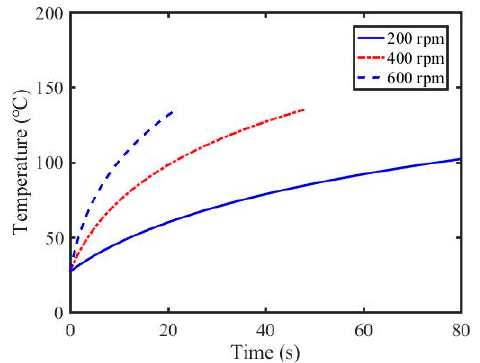
Figure 4. Internal temperature of the VC.